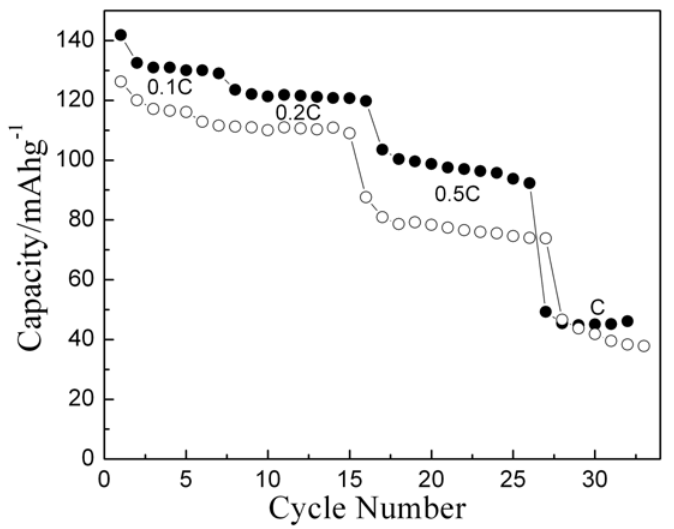
Figure 7. Rate capability plot for Li/LiCoO 2 cells for nitrate derived (- ● -) and solid-state prepared (- ○ -)